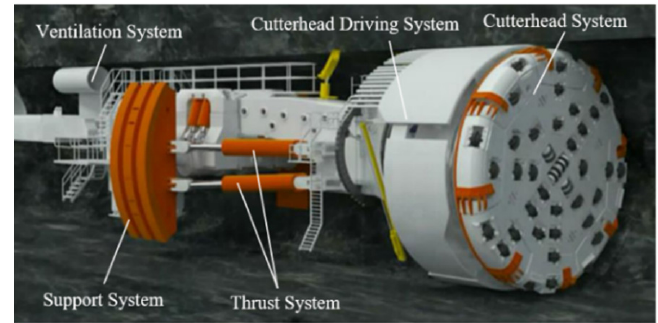
Figure 1. A typical diagram of the TBM. Reproduced with permission from [3], Springer Nature , 2016.